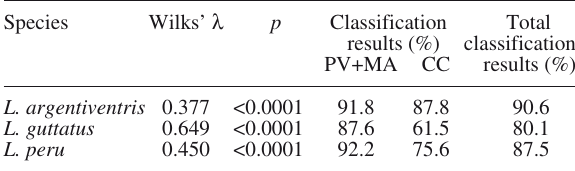
Table 4. – Classification results a,b,c of discriminant analysis of fish scale shape for the two geographic variants (PV, Puerto Val- larta; MA, Manzanillo; and CC, Caleta de Campos). Total clas- sification success for cross-validated predicted geographic variant